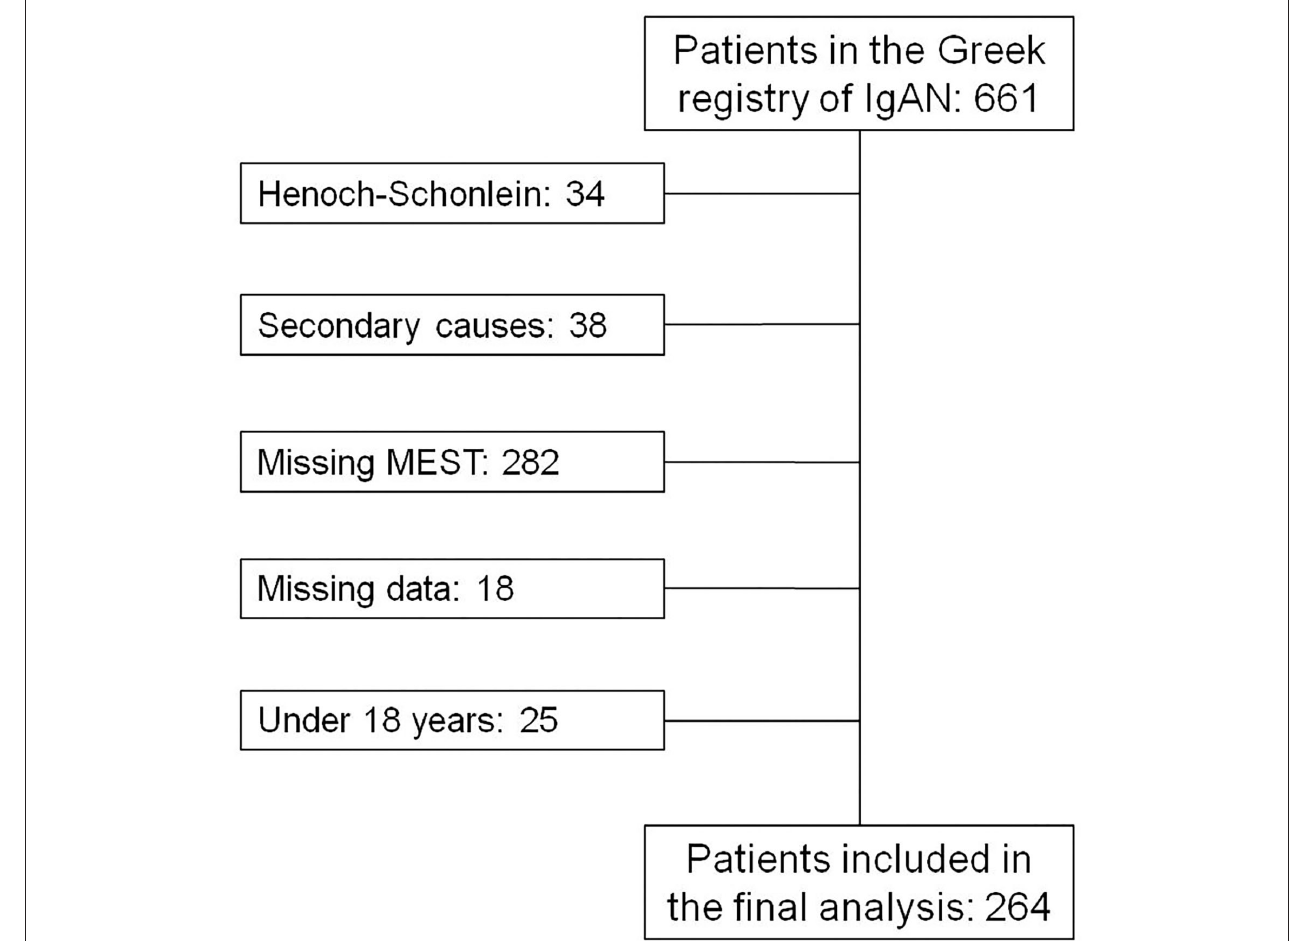
FIGURE 1 | Flow chart of patients finally included in the analysis.